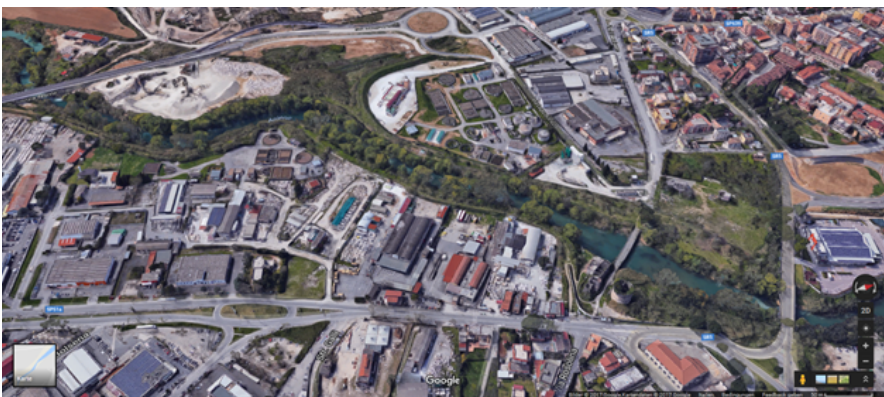
Figure 5. Bird eye view of ‘Ponte Lucano’ and ‘Tomba dei Plauzi’ in Tivoli, showing the industrial and flood-prone downstream area of the river [retrieved from Google Maps 20 July 2020].